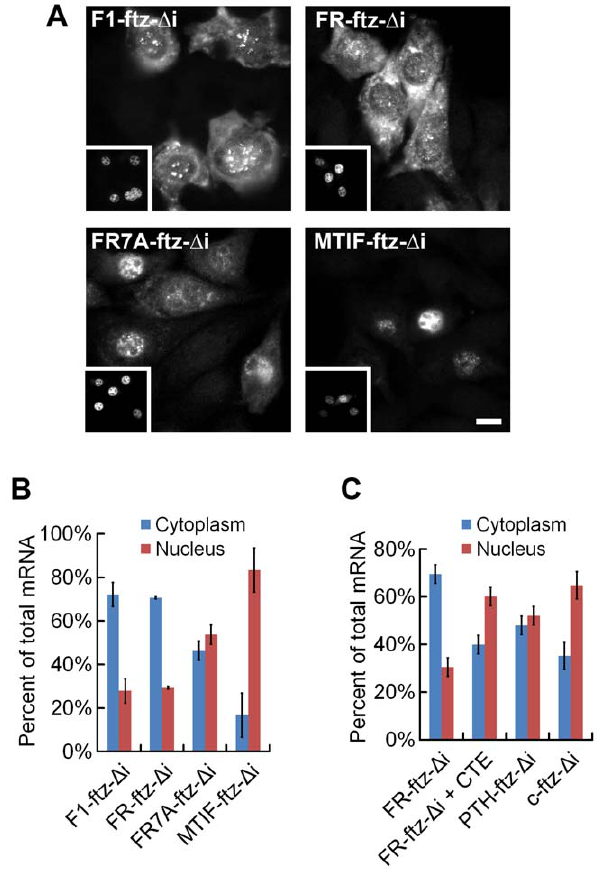
Figure 5. MSCRs derived from 5UI 2 genes promote mRNA nuclear export. Transcripts encoding various versions of ftz (see Figure S4 for all modified ftz sequences) were microinjected along with fluorescent 70 kD dextran as in Figure 3. Panels A and B are as described for Figure 3. (C) DNA plasmids containing the indicated ftz genes and fluorescent 70 kD dextran were microinjected alone, or with the CTE viral RNA, into the nuclei of NIH 3T3 fibroblasts. Cells were allowed to express the ftz RNAs for 20 min then further transcription was inhibited by a -amanitin treatment. After allowing the mRNA to be exported for 2 hours, the cells were fixed and ftz mRNA was detected by fluorescence in situ hybridization. The distribution of ftz mRNA was quantified as described in Figure 3B.